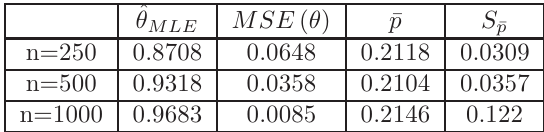
Simulations for Cox PH model, Trinomial